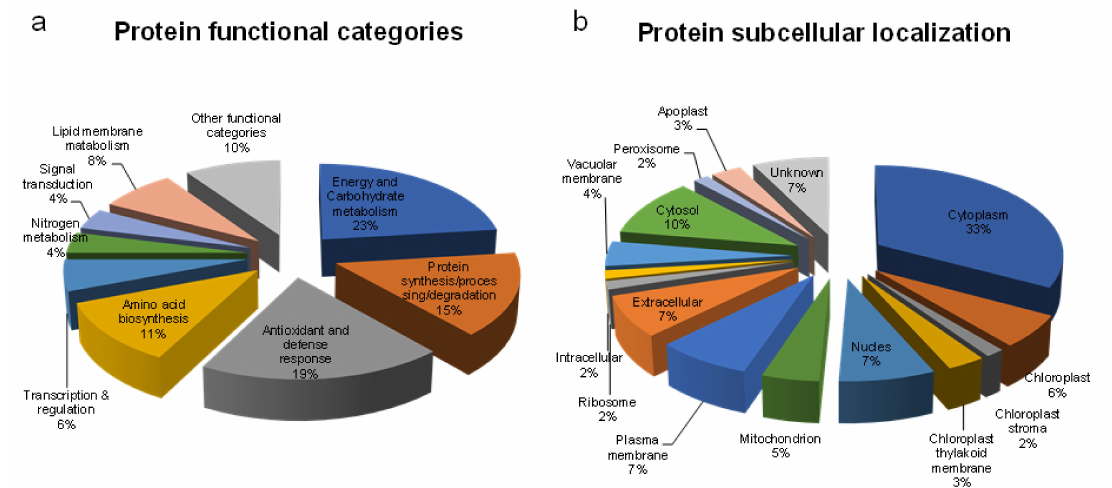
Figure4. Thefrequencydistributionforthe52identified proteinsinthe rootof sorghumseedlingswithin functional categories determined based on their biological functions ( a ) and subcellular localization ( b